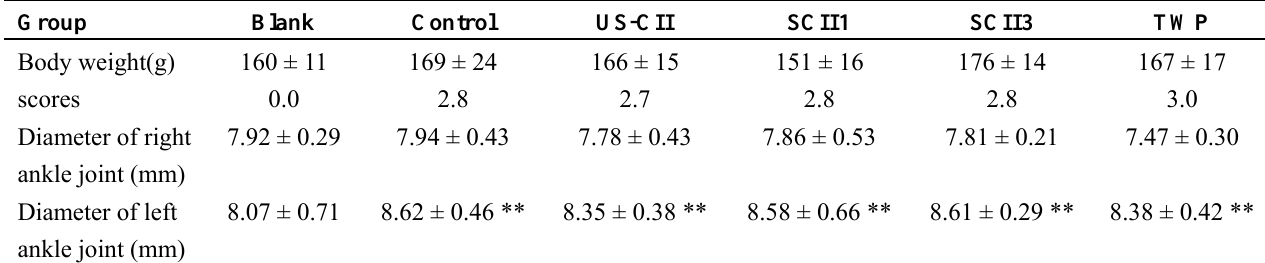
Table 1. The clinical manifestations in 2 weeks for each experiment group after injecting CFA or acetic